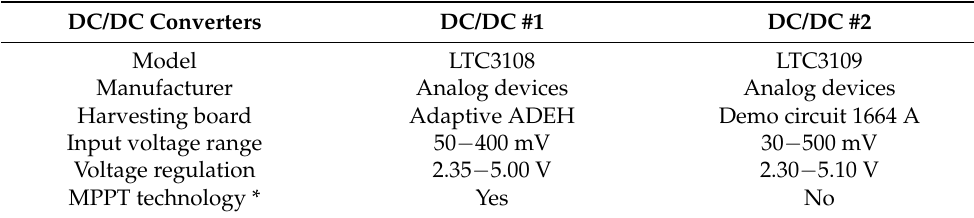
Table 3. Analyzed DC/DC